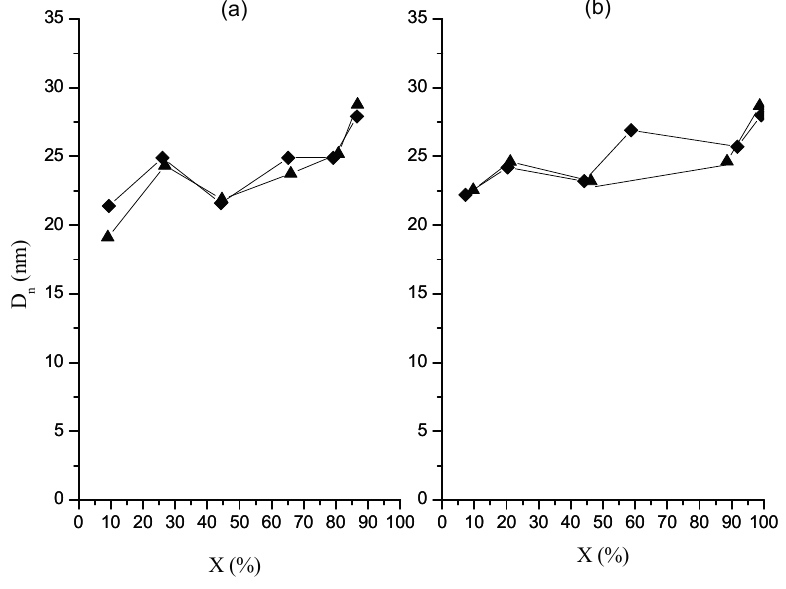
Figure 2. Number average diameter measured by STEM as a function of global conversion in polymerizations at F o 0.05 ( a ) and 0.15 ( b ) g/min. Runs M ( ♦ ); runs MR ( ▲ ).